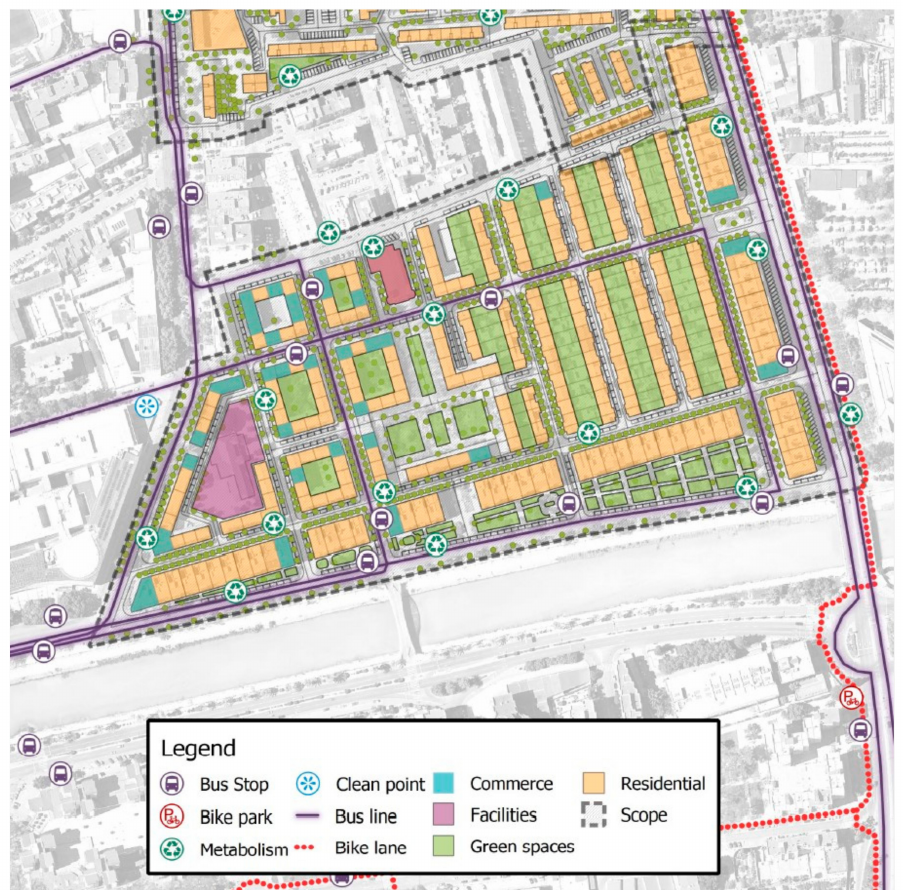
Figure 7. Mapping of Vistabella neighborhood in QGis. Stores and facilities. Public transportation and bicycle lanes. Green areas and routes. Authors’